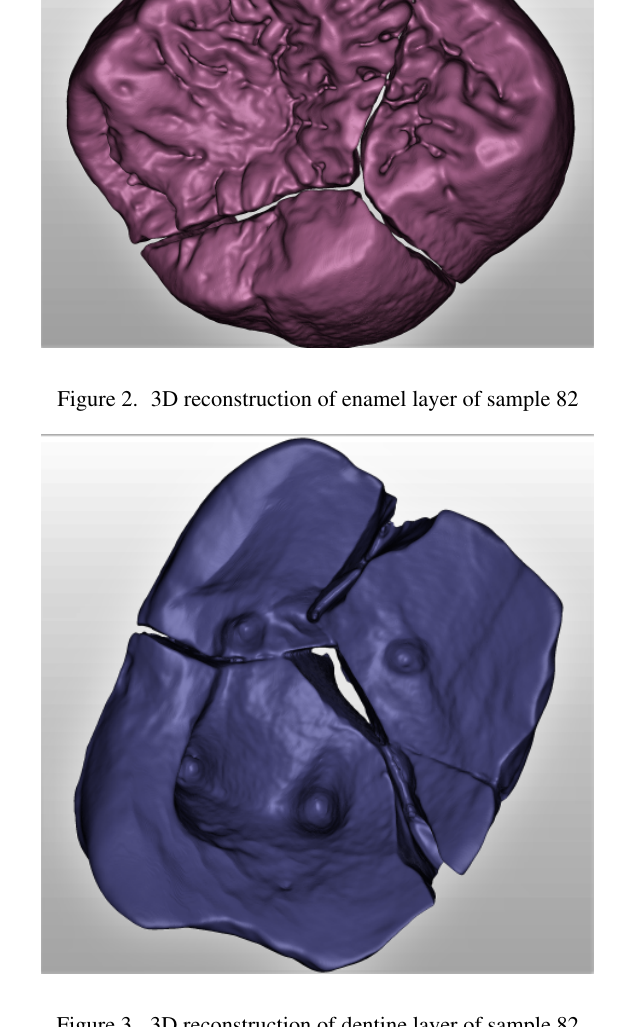
Figure 3. 3D reconstruction of dentine layer of sample